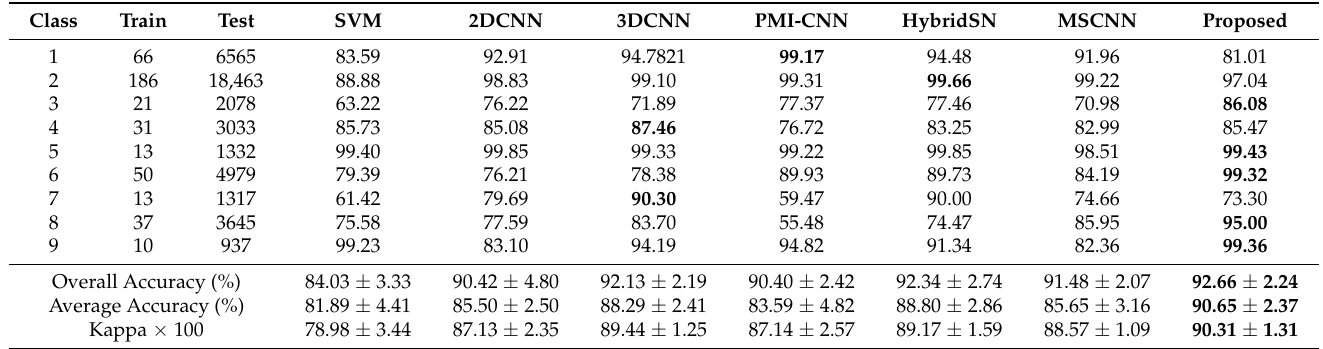
Table 7. Classification results on the PU dataset with 1% labeled training samples. The best accuracy is shown in